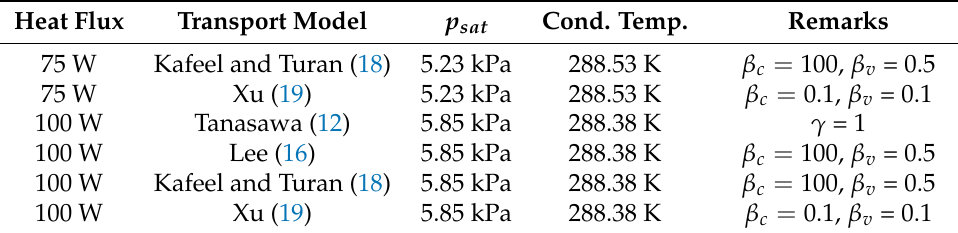
Table 2. Initial conditions and model settings